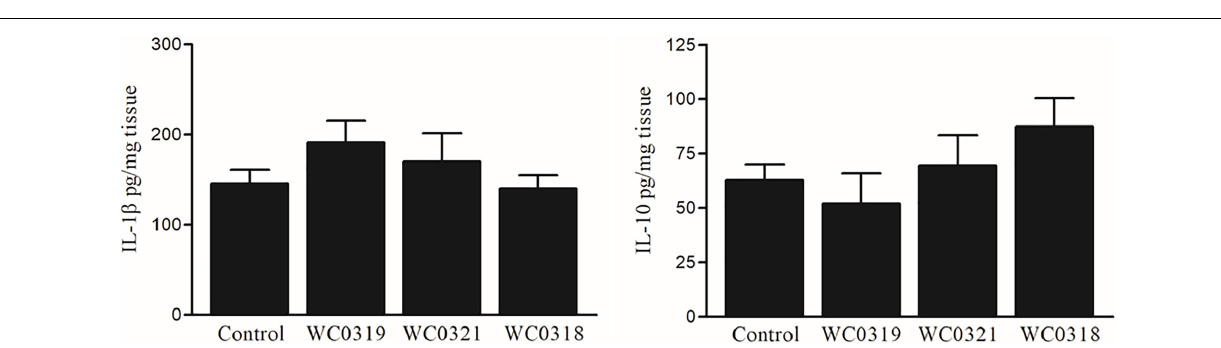
FIGURE 7 | Effect of daily oral supplementation with 5 × 10 8 CFU of Leuconostoc carnosum WC0318, L. carnosum WC0319, and L. carnosum WC0321 on intestinal mucosa IL-1 β and IL-10, quantified by ELISA. Cytokine levels were expressed as pg/ml of tissue lysate. Means did not significantly differ from the control ( p > 0.05, t